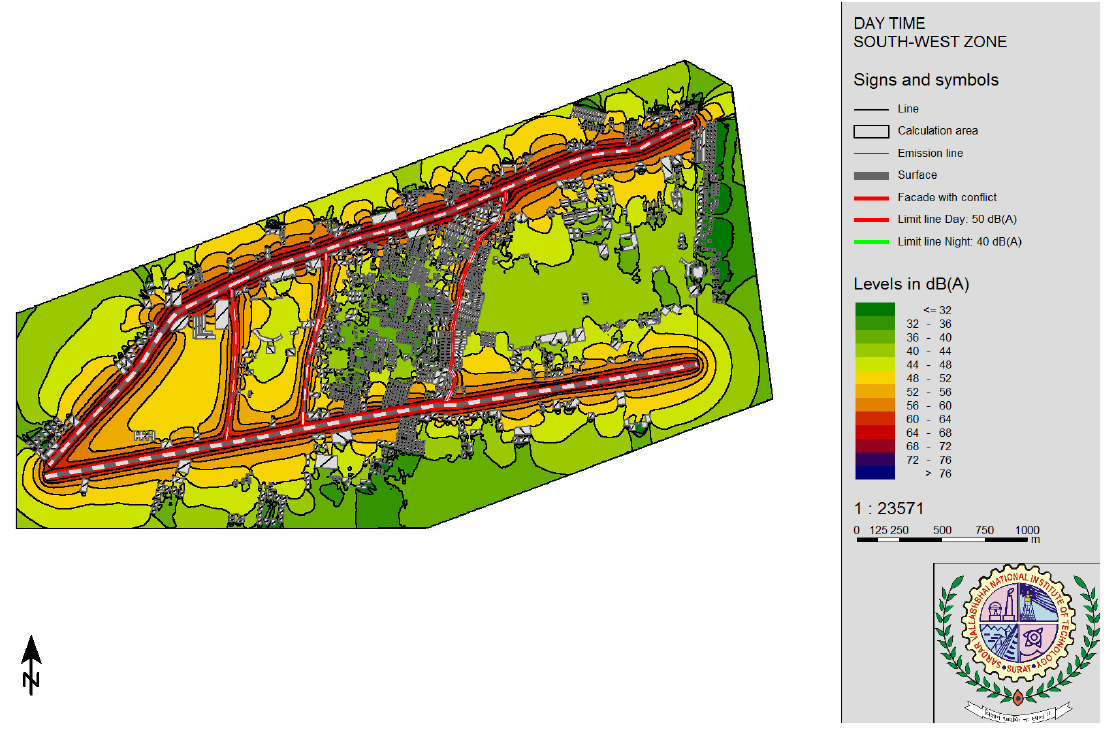
Figure 5: Day time noise map of South-West zone using RLS-90